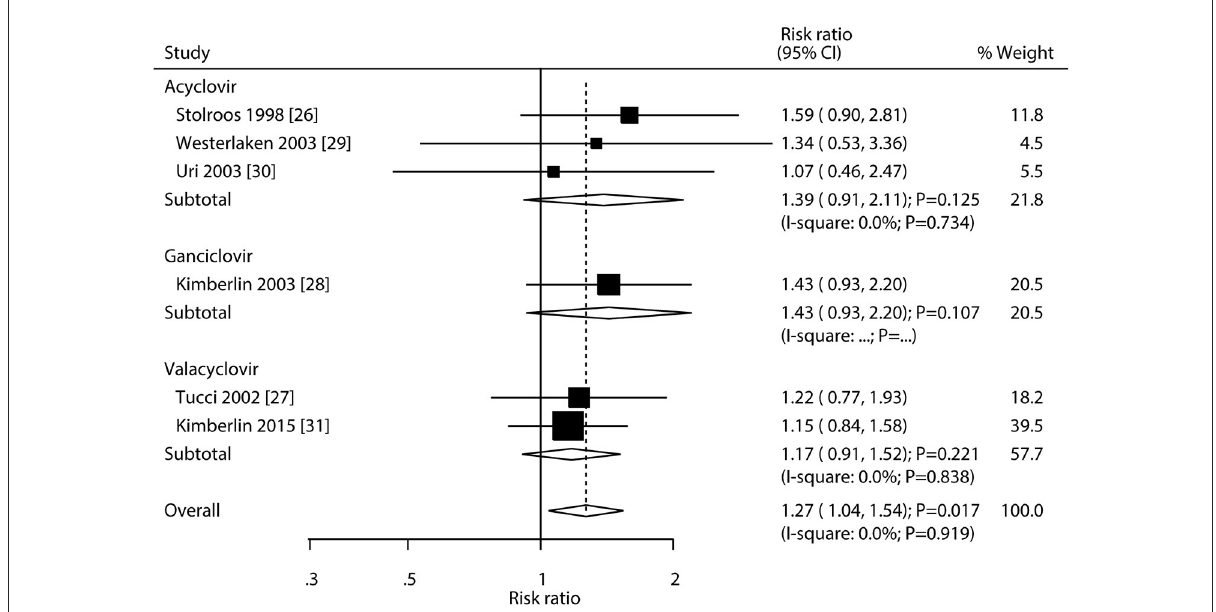
FIGURE6 Forest plot of the meta-analysis of the incidence of hearing recovery between antivirals and placebo.